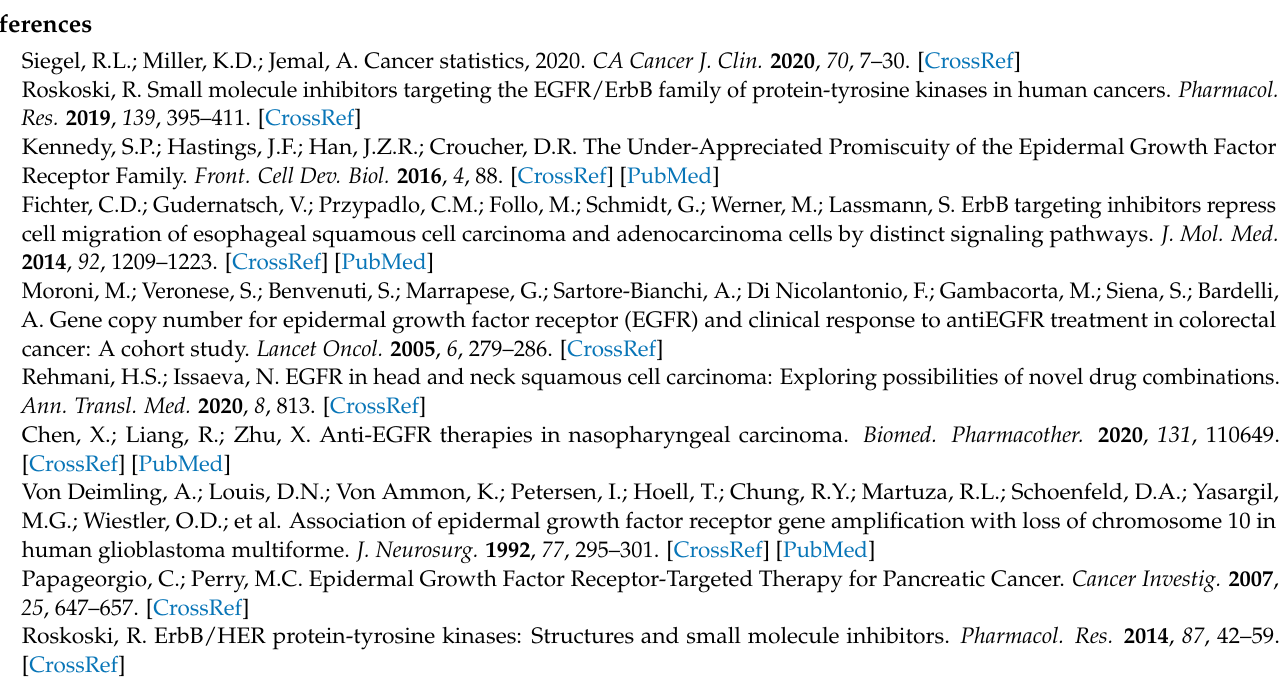
tallographic data, details of data collection and structure refinement parameters for compound 3 , Figure S1: three-dimensional supramolecular network derived from intramolecular interactions of compound 3 . Figures S2 to S10: corresponding IR, 1 H and 13 C NMR spectra of compounds 1 to 3